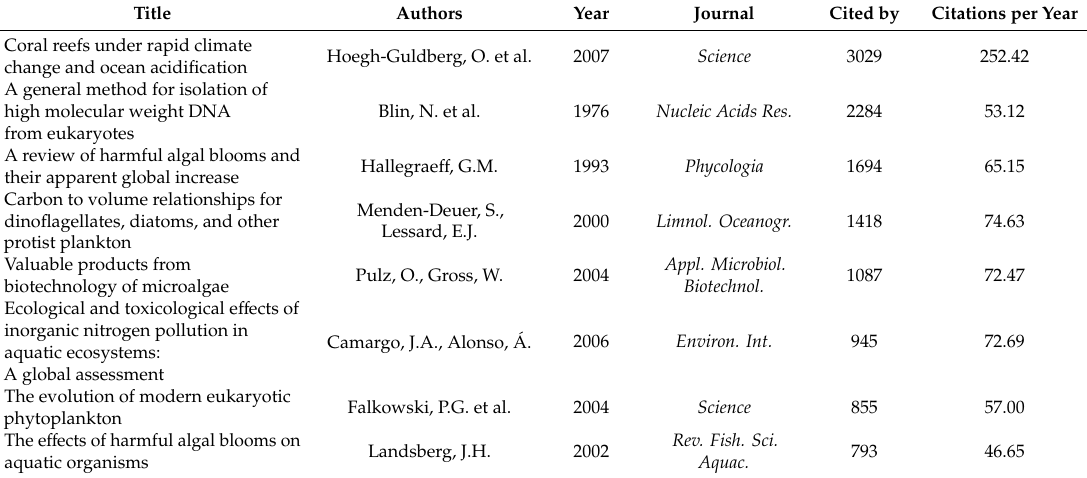
Table 4. Top 20 mostly cited publications on dinoflagellate